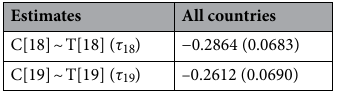
Table 3. Estimates for the multiphase model coefficients along with standard error (in small bracket) having time invariant covariates (TICs) and time-varying covariates (TVCs). TIC time invariant covariates; TVC time varying